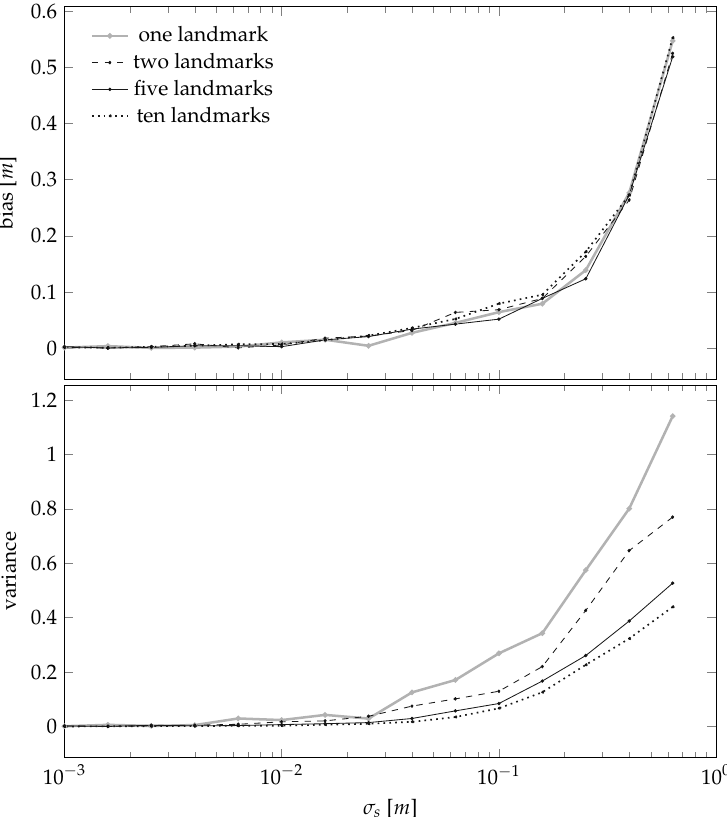
Figure 8. Bias and variance of the landmark position estimator of Section 3.1 as a function of the number of landmarks L for the case σ θ = 2.